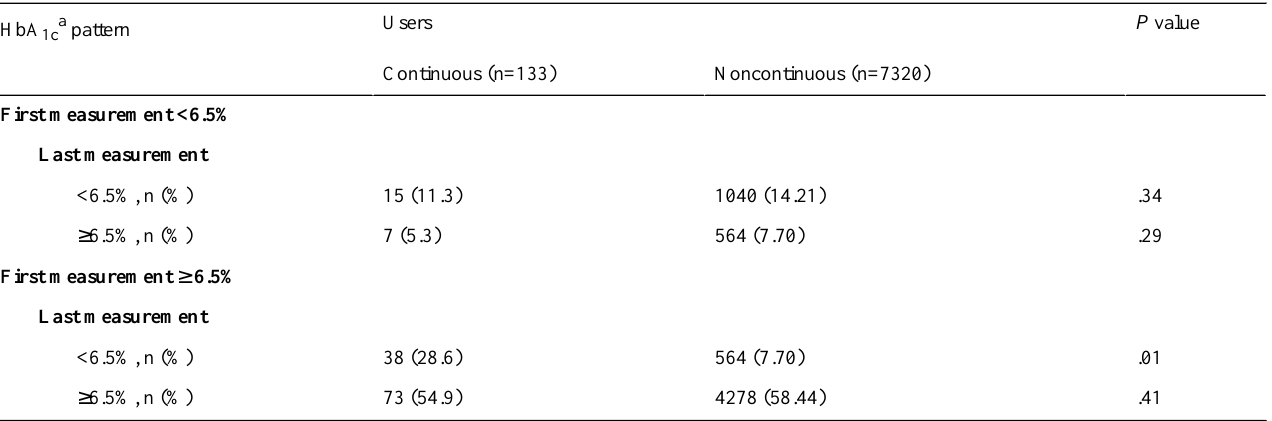
Table 3. Pre– and post–hemoglobin A 1c management comparison by continuous use.